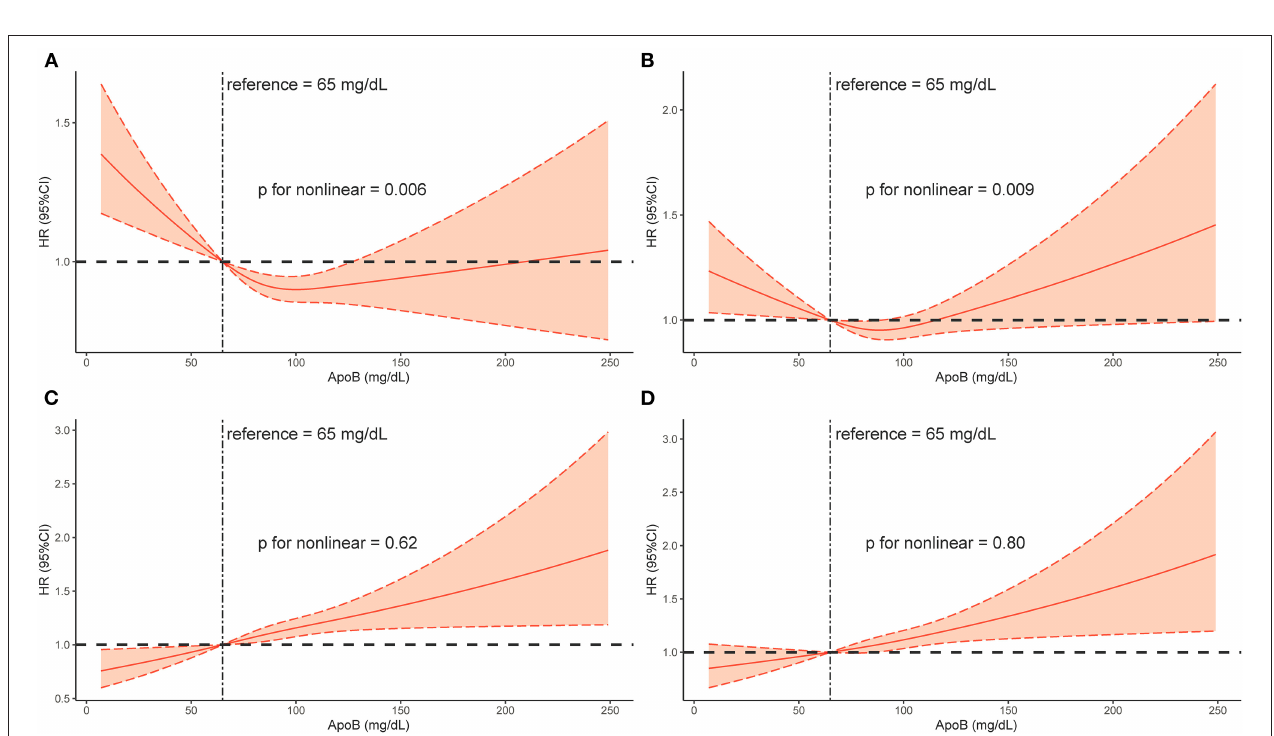
FIGURE 5 | Restricted spline curve of the Baseline ApoB hazard ratio for mortality (long-term all-cause mortality) in CAD patients. (A) : Model 1, Unadjusted model. (B) : Model 2, Adjusted for age ≥ 75 years, sex, PCI and comorbidities including AMI, CHF, hypertension, diabetes mellitus, CKD, anemia, atrial fibrillation, COPD and stroke. (C) : Model 3, Adjusted for malnutrition. (D) : Model 4, Adjusted for all covariates: age ≥ 75 years, sex, PCI and comorbidities including AMI, CHF, hypertension, diabetes mellitus, CKD, anemia, atrial fibrillation, COPD, stroke and